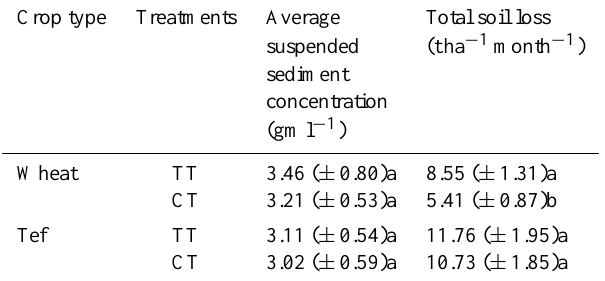
Table 2. Runoff sediment concentration and total soil loss of the different farm plots during (23 August to 24 September 2010 at Enerata).